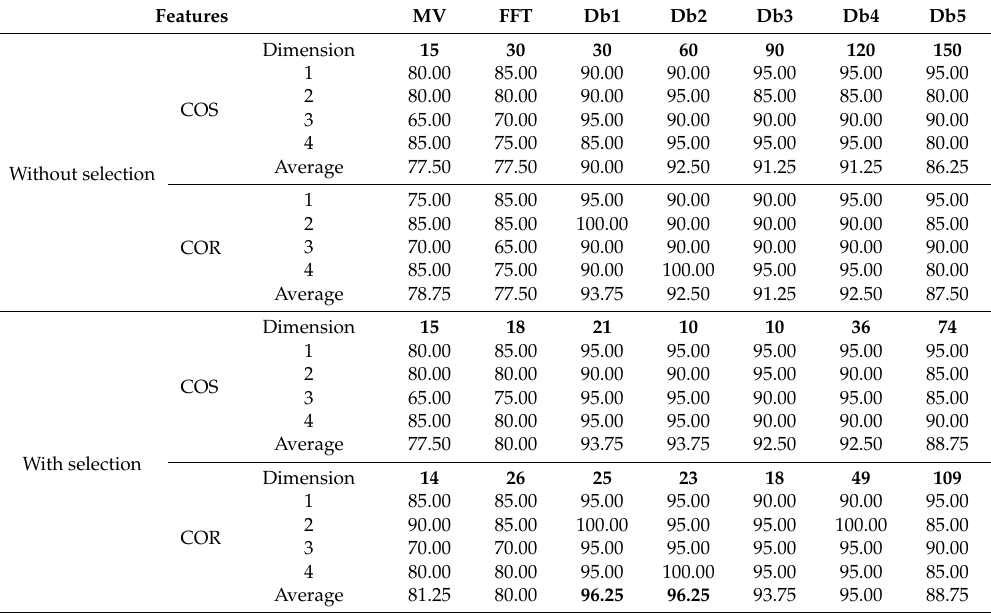
Table 9. Classification accuracy of Dataset I with/without feature selection.